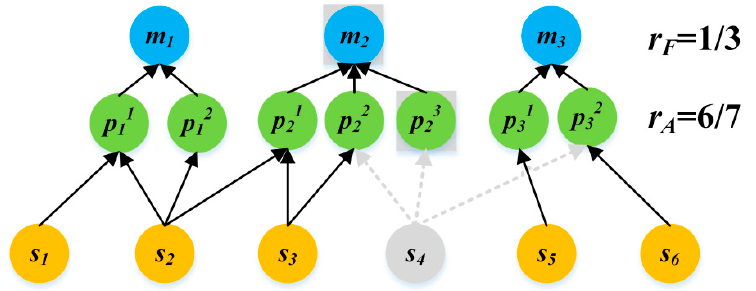
Figure 2. Calculation of two proposed performance metrics.